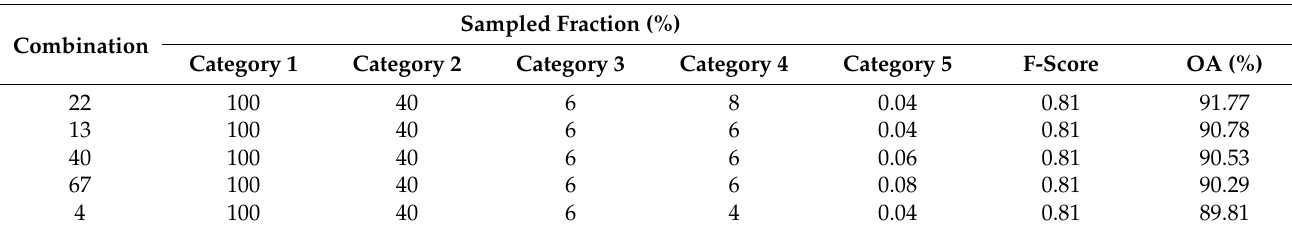
Table 3. Highest accuracy scores for the evaluated category sampling fraction